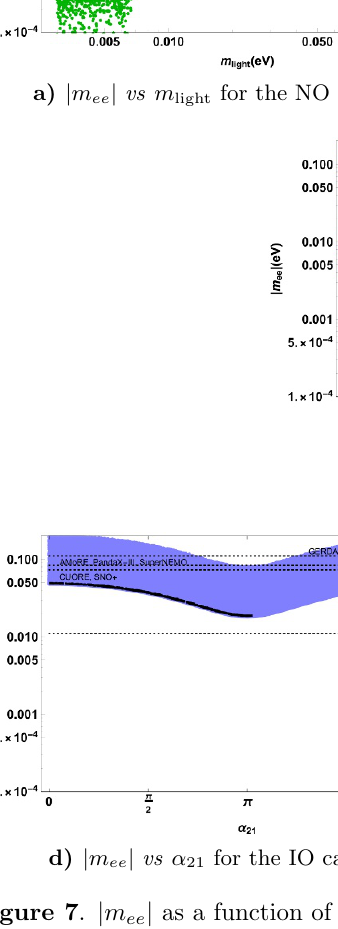
Figure 7 . j m ee j as a function of m light in a) for the NO case and in b) for the IO one. j m ee j as a function of the Majorana phases for the NO case in c) and for the IO one in d) and